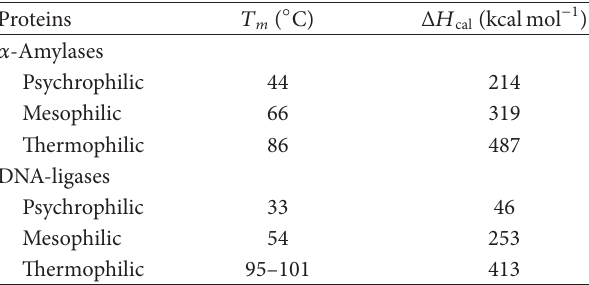
T 4: Microcalorimetric parameters of thermal unfolding shown in Figure